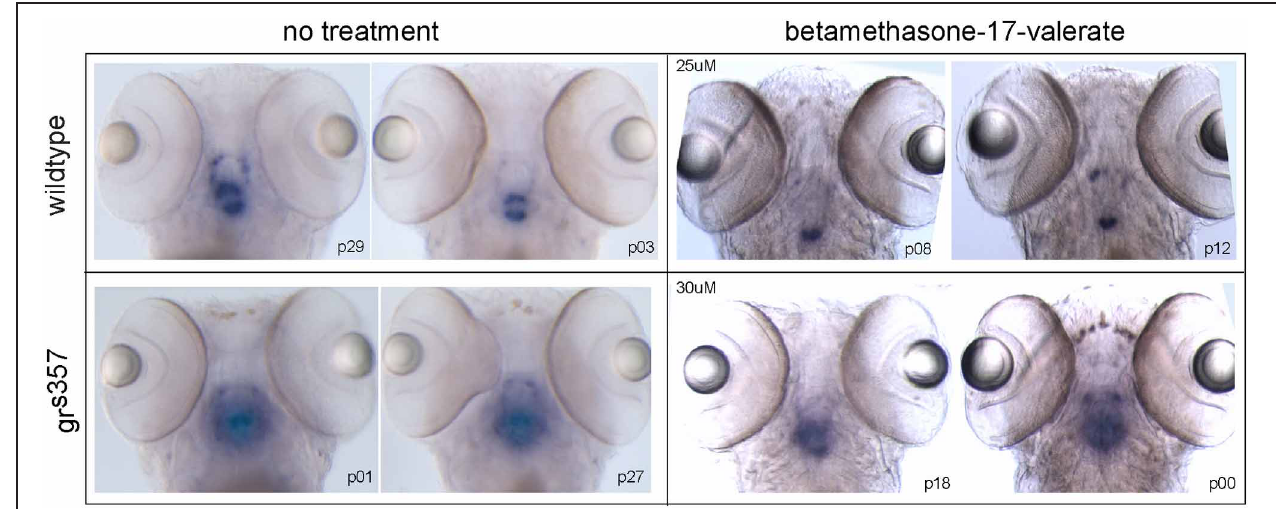
FIGURE 4 | RNA in situ hybridization for pomc transcript in 5 day old larvae. Results are presented from a 2 × 2 experimental design testing the effects of genotype (rows) and betamethasone 17-valerate treatment (columns) on pomc expression. Two representative larvae per group